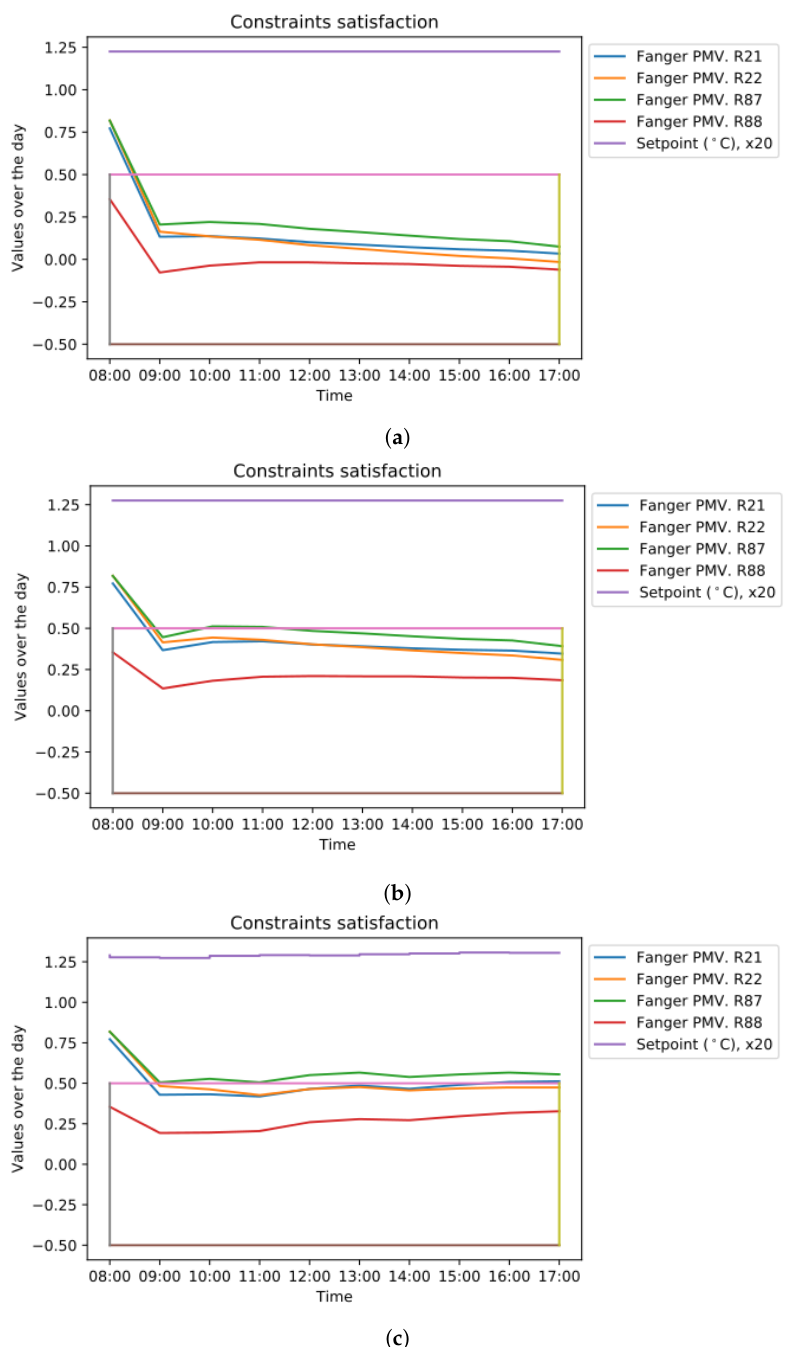
Figure 6. The experimental results for the controlled/occupied period within one simulation day: ( a ) the performance of the simple rule-based controller with the setpoint 24.5 ◦ C; ( b ) he performance of the best controller ranked by the MCDA method with the setpoint 25.5 ◦ C; and ( c ) the performance of the optimised controller discovered by the GP_SS method with the setpoint varying per timestep, attaining values between 25.4 ◦ C and 26.1 ◦